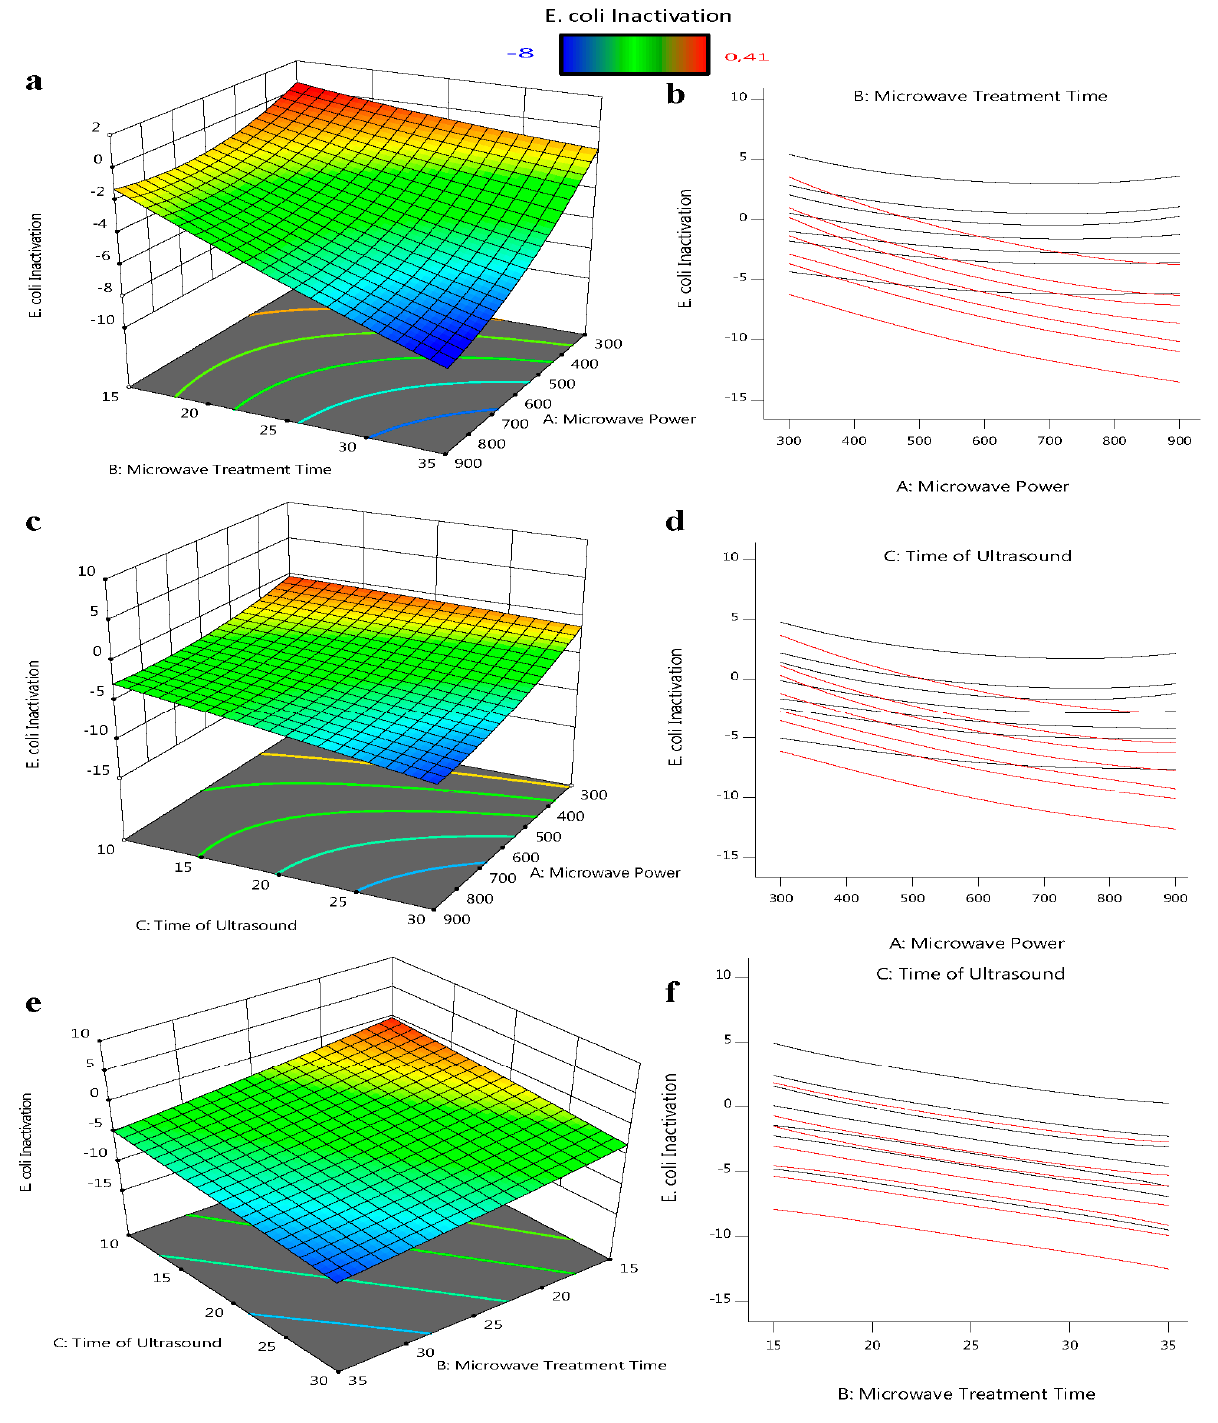
Figure 2. Three-dimensional response surface plots showing the influence of process factors on E. coli ATCC 25922: ( a , b ) the microwave treatment time and microwave power intersection; ( c , d ) the time of ultrasound and microwave power intersection; and ( e , f ) the time of ultrasound and microwave treatment time intersection for E. coli reduction.